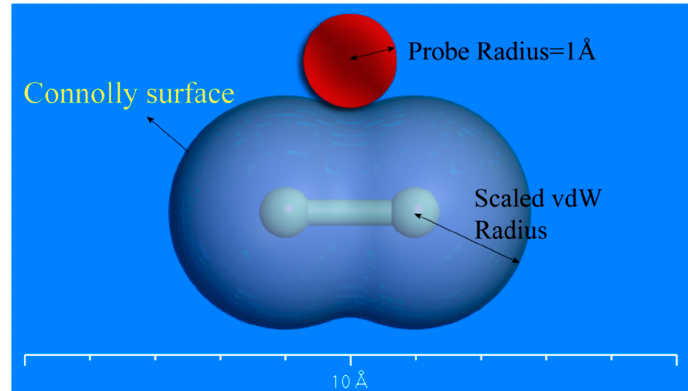
Figure 7. The colored curves are stress–strain curves of EPDM, the star curve is the uniaxial